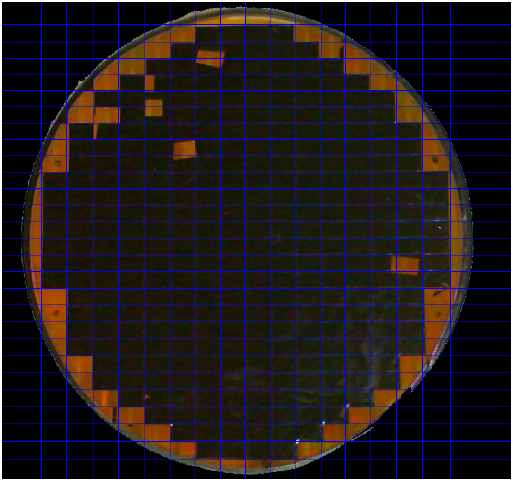
Figure 16. The final result of the detected die sawing